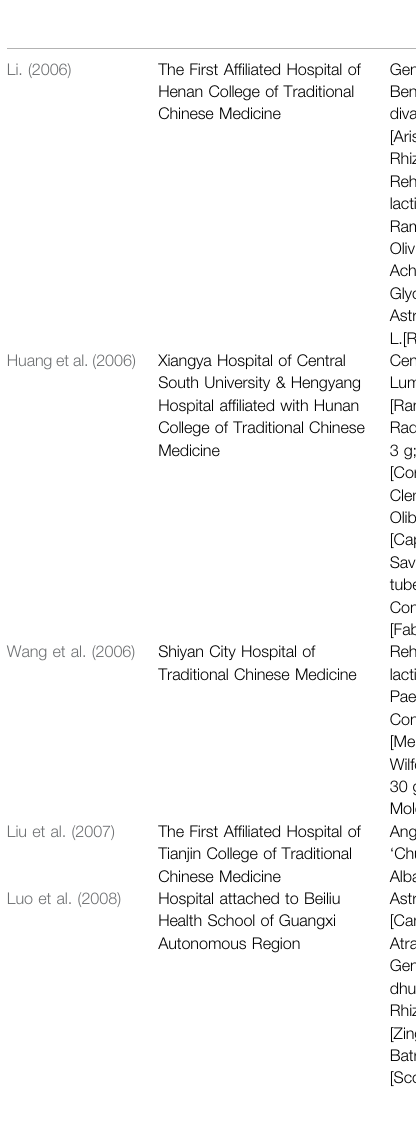
TABLE 2 | A summary table describing the composition of the CMCs. Study Source Species,